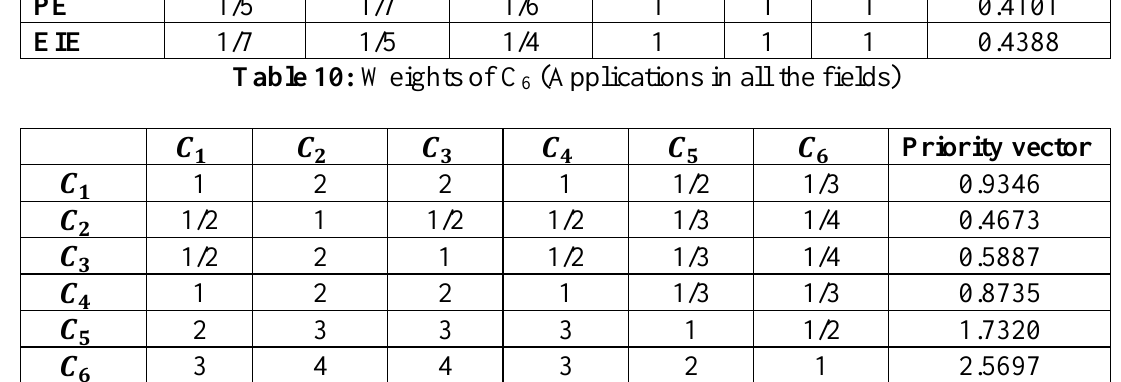
Table 11: Weight Vectors of all Criteria